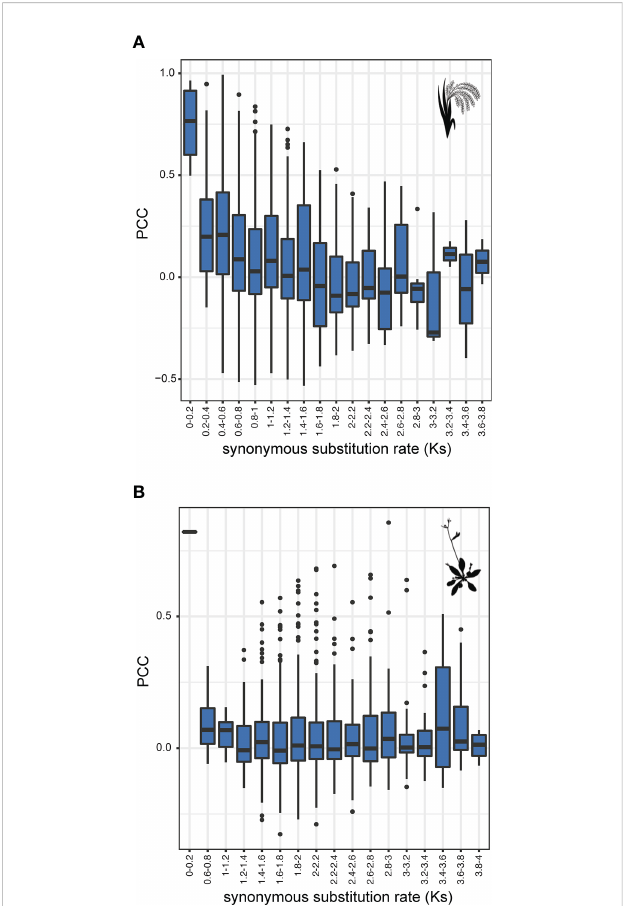
FIGURE 5 Relationship between synonymous substitutions (Ks) and expression correlation of BAHD paralogs. Expression correlation (PCC) versus synonymous substitution rate (Ks) of (A) rice and (B) Arabidopsis BAHDs. No signi fi cant differences were found when comparing across the entire dataset (Kruskal-Wallis rank sum test p=0.121 and p=0.494, respectively). However, comparing individual Ks bins for rice using pairwise Kolmogorov-Smirnov tests revealed signi fi cant differences between bin 0-0.2 in several bins up to bin 2.6-2.8 (signi fi cance level